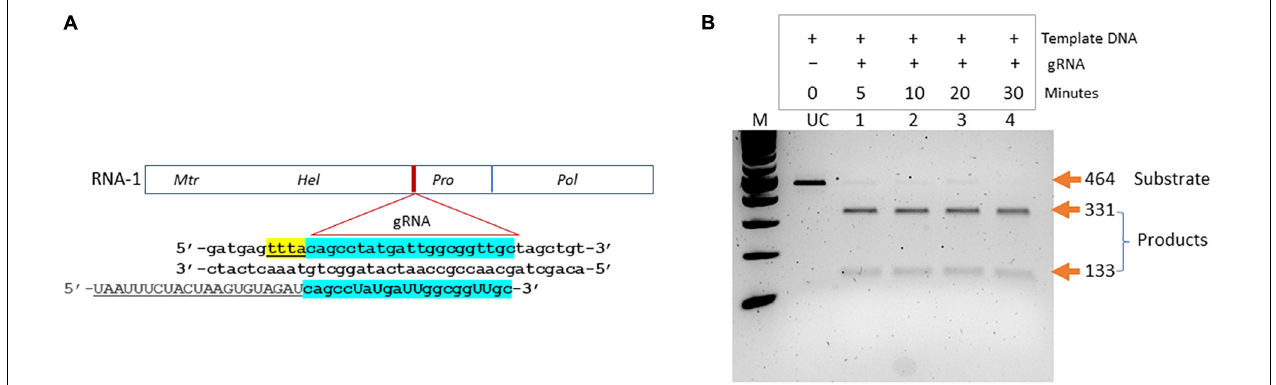
FIGURE 2 | Validation of designed guide (g)RNA targeting BNYVV genome. (A) Diagrammatic representation of BNYVV RNA1 genome showing the location of the guide RNA (gRNA) target site and the corresponding sequence information. Sequence keys: gRNA, blue highlight; CRISPR-RNA, underlined; and PAM, yellow highlight. (B) In vitro activity assay. Substrate (464 bp), linear dsDNA fragments comprising the target sequence are assayed along with the guide RNA and resolved on agarose gel electrophoresis. Products refer to cleaved DNA fragments (331 and 133 bp). Lanes 1–4, time course analysis in 5, 10, 20, and 30 min indicated at the top of the gel image. UC refers to uncut template DNA.